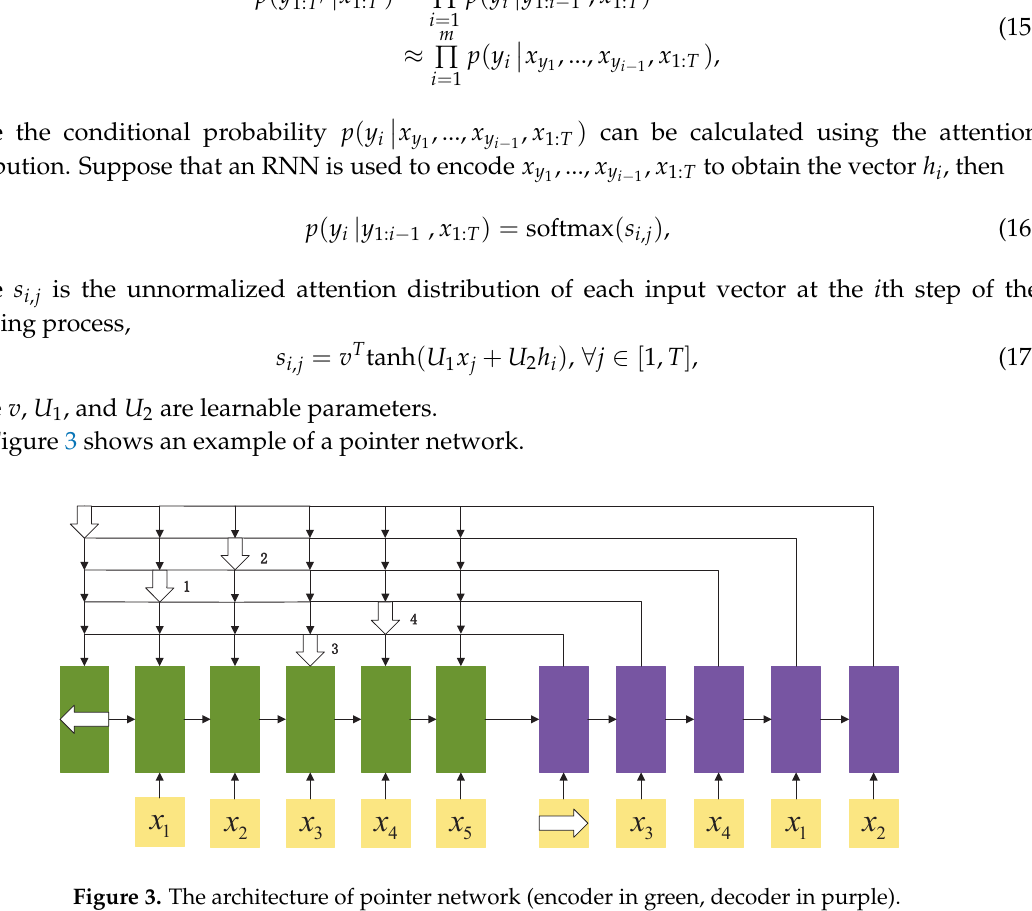
Figure 3. The architecture of pointer network (encoder in green, decoder in